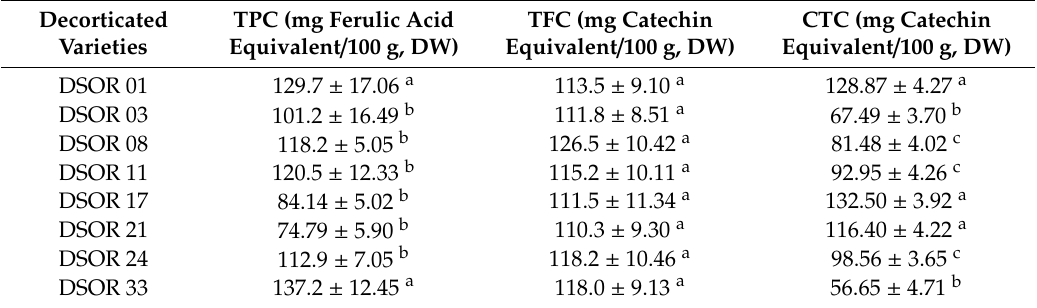
Table 1. Total phenolic content (TPC), total flavonoid content (TFC) and total condensed tannins content (CTC) of decorticated sorghum